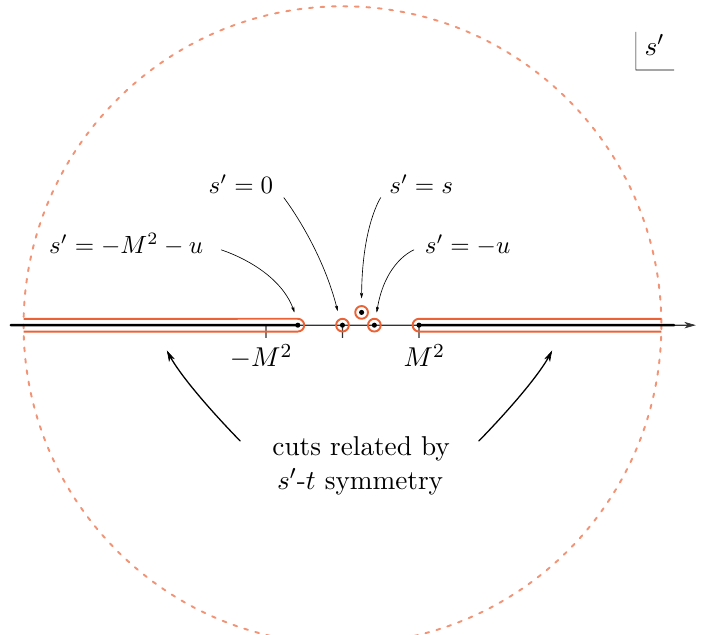
Figure 1 . The dispersion relation used in (3.2) starts from the contour at infinity (dashed). The contour is deformed inwards, picking up contributions from the three poles indicated and from two cuts on the real s 0 axis, starting at M 2 and − M 2 − u respectively. Based on the assumed symmetry s 0 ↔ t = − s 0 − u , the integrals over the two cuts can be